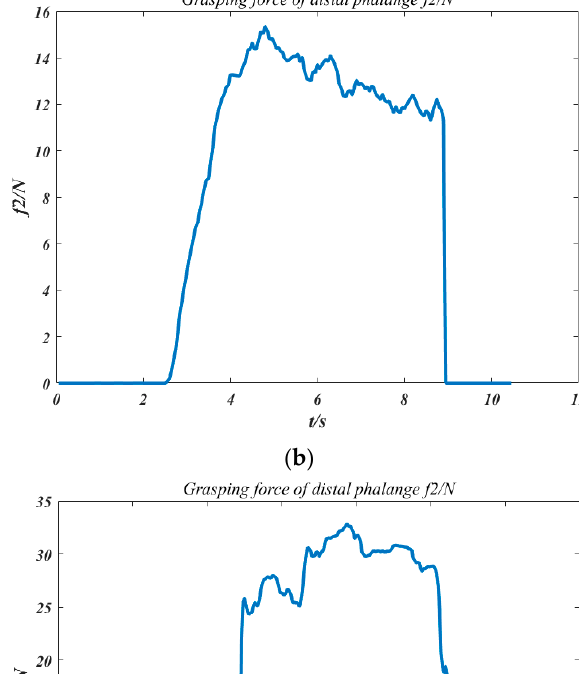
Table 3. Grasping force of the ESMGM hand during grasping experiments.